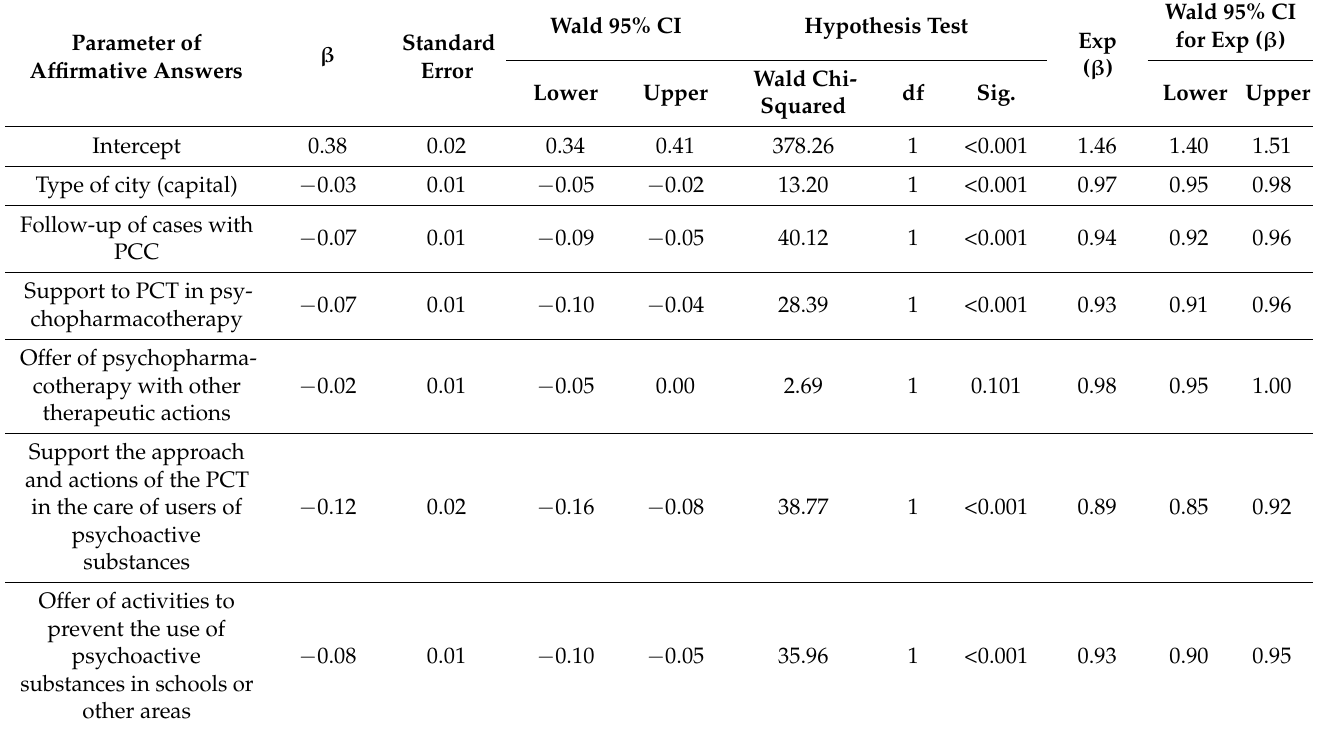
Table 3. Poisson regression analysis of consensus criteria and flows between primary care teams (PCT) and family health support center (NASF) for mental health care in PHC and specialized services in capital cities of Brazil